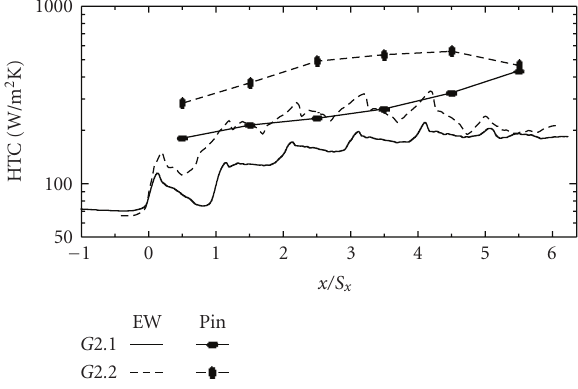
Figure 6: Endwall spanwise averaged and pin fin HTC—Re d 5 =